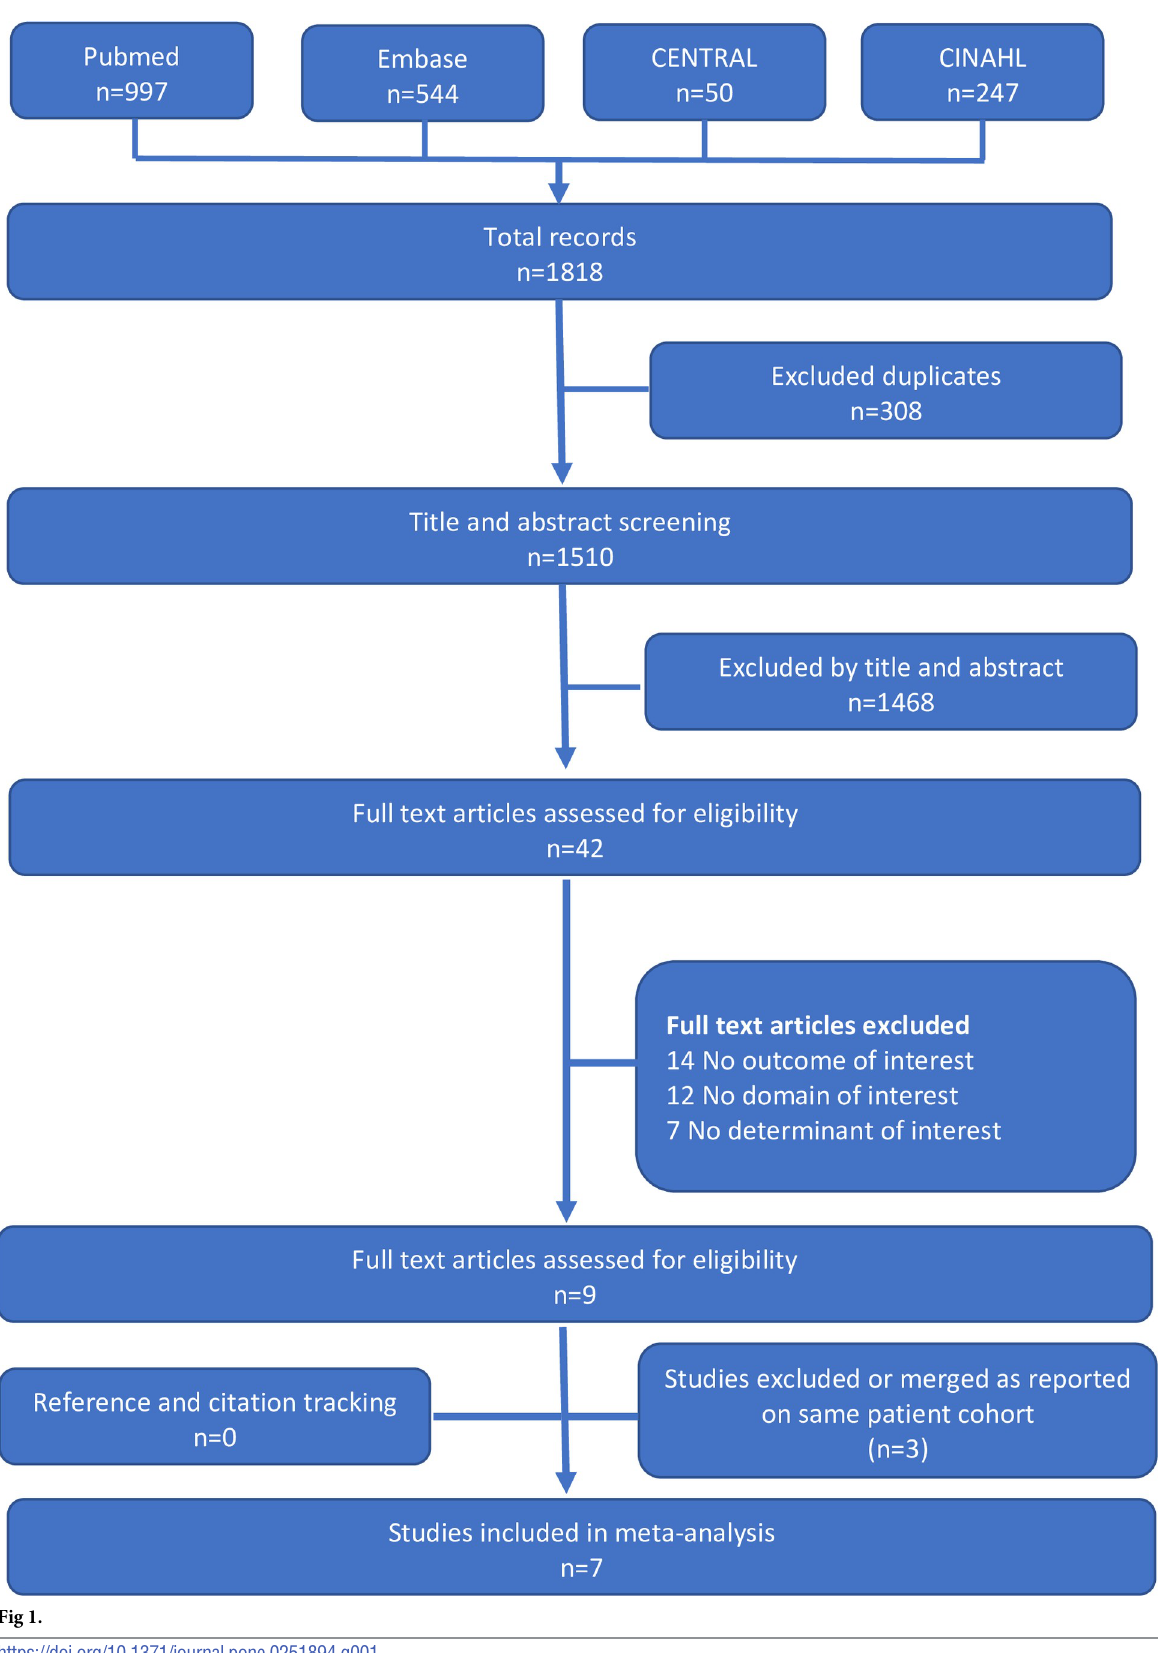
Fig 1. https://doi.org/10.1371/journal.pone.0251894.g001 PLOS ONE | https://doi.org/10.1371/journal.pone.0251894 June 15,